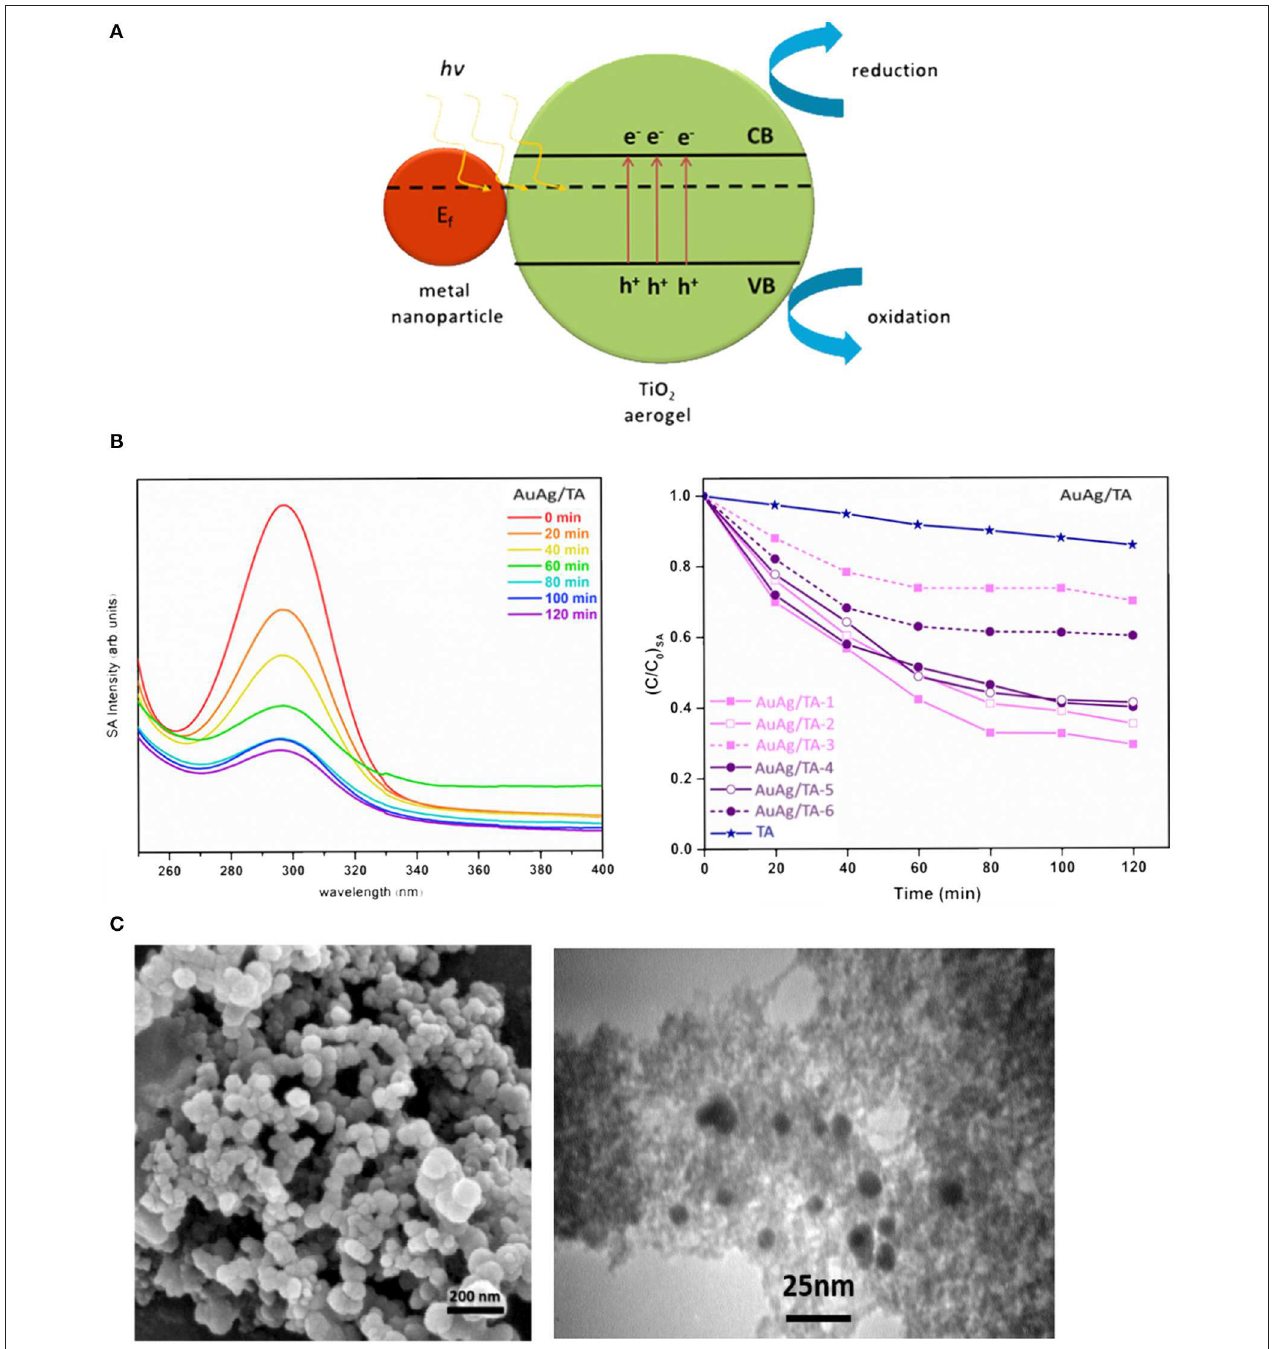
FIGURE 5 | (A) Schematic of plasmonic AuAg/TA, (B) photocatalytic performances of different AuAg/TA and pure TA, and (C) FESEM and TEM images of AuAg/TA. Reprinted from Sadrieyeh and Malekfar (2018b), © 2018, with permission from